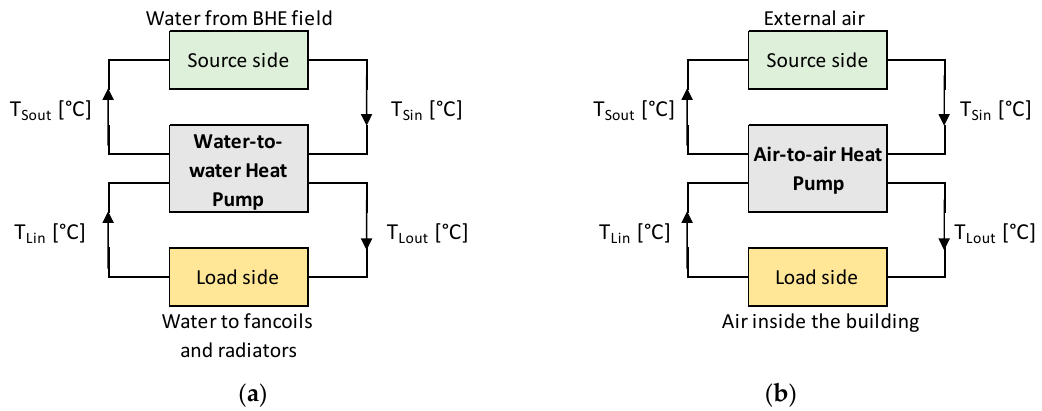
Figure 1. Scheme of HP operating conditions, ( a ) water-to-water HP, ( b ) air-to-air HP (without heat recovery).